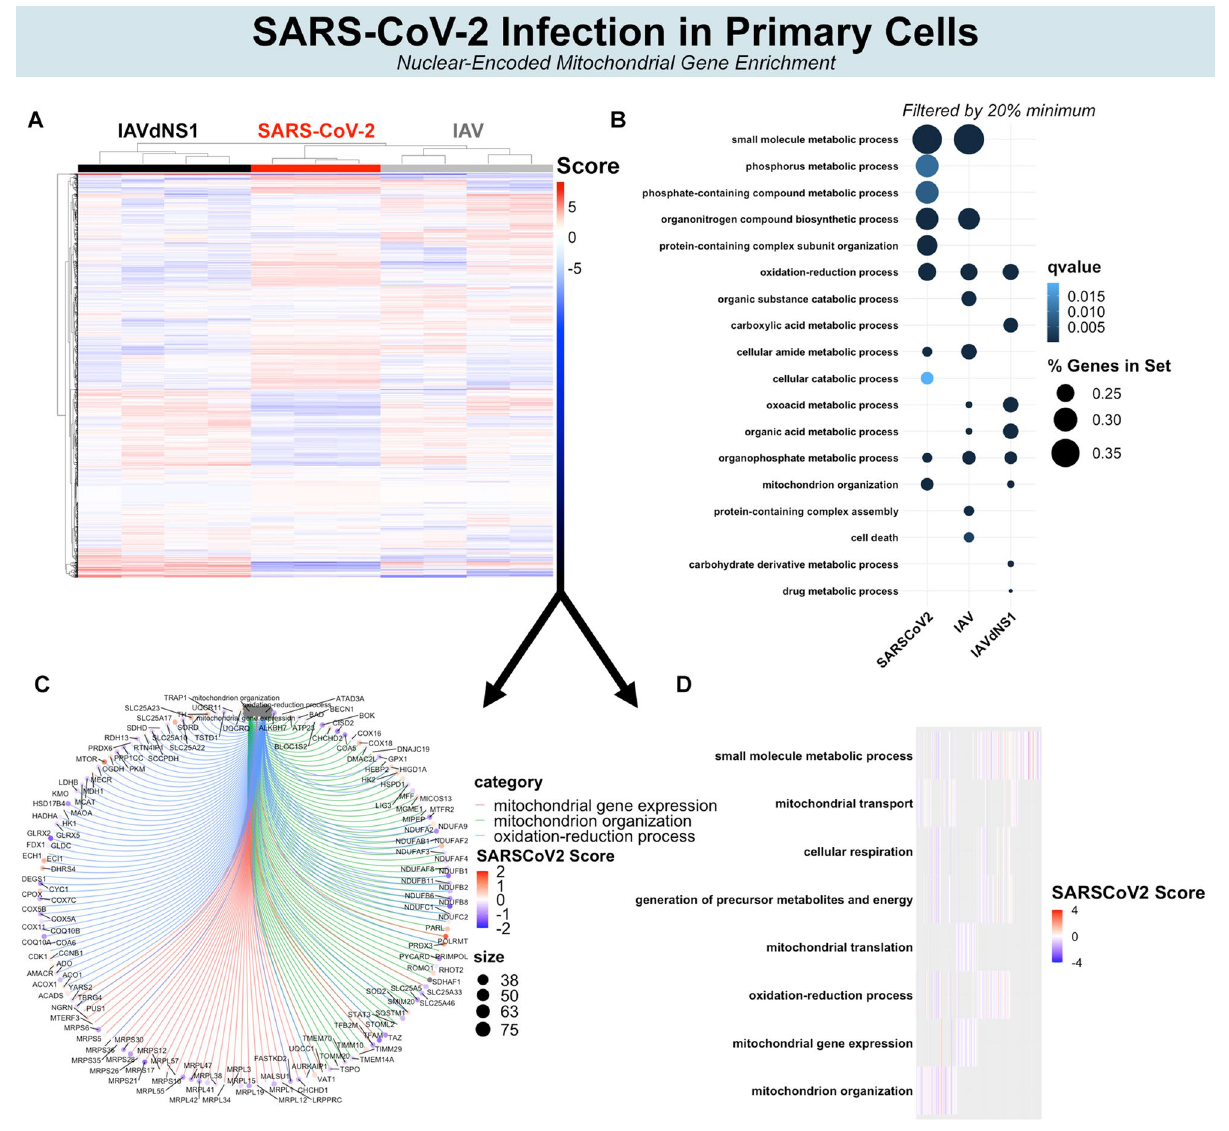
Figure 3. Biological processes affected by NEM expression. Hierarchical clustering of all NEMs separate SARS- CoV-2, IAV, and IAVdNS1 ( A ). Top NEM biological processes by > 20% gene set enrichment ( B ). Top NEM biological processes by q value ( C ). Circos plot illustrating significant NEMs and interconnectedness among biological processes. ( D ) Heat map representing the top 10 GO